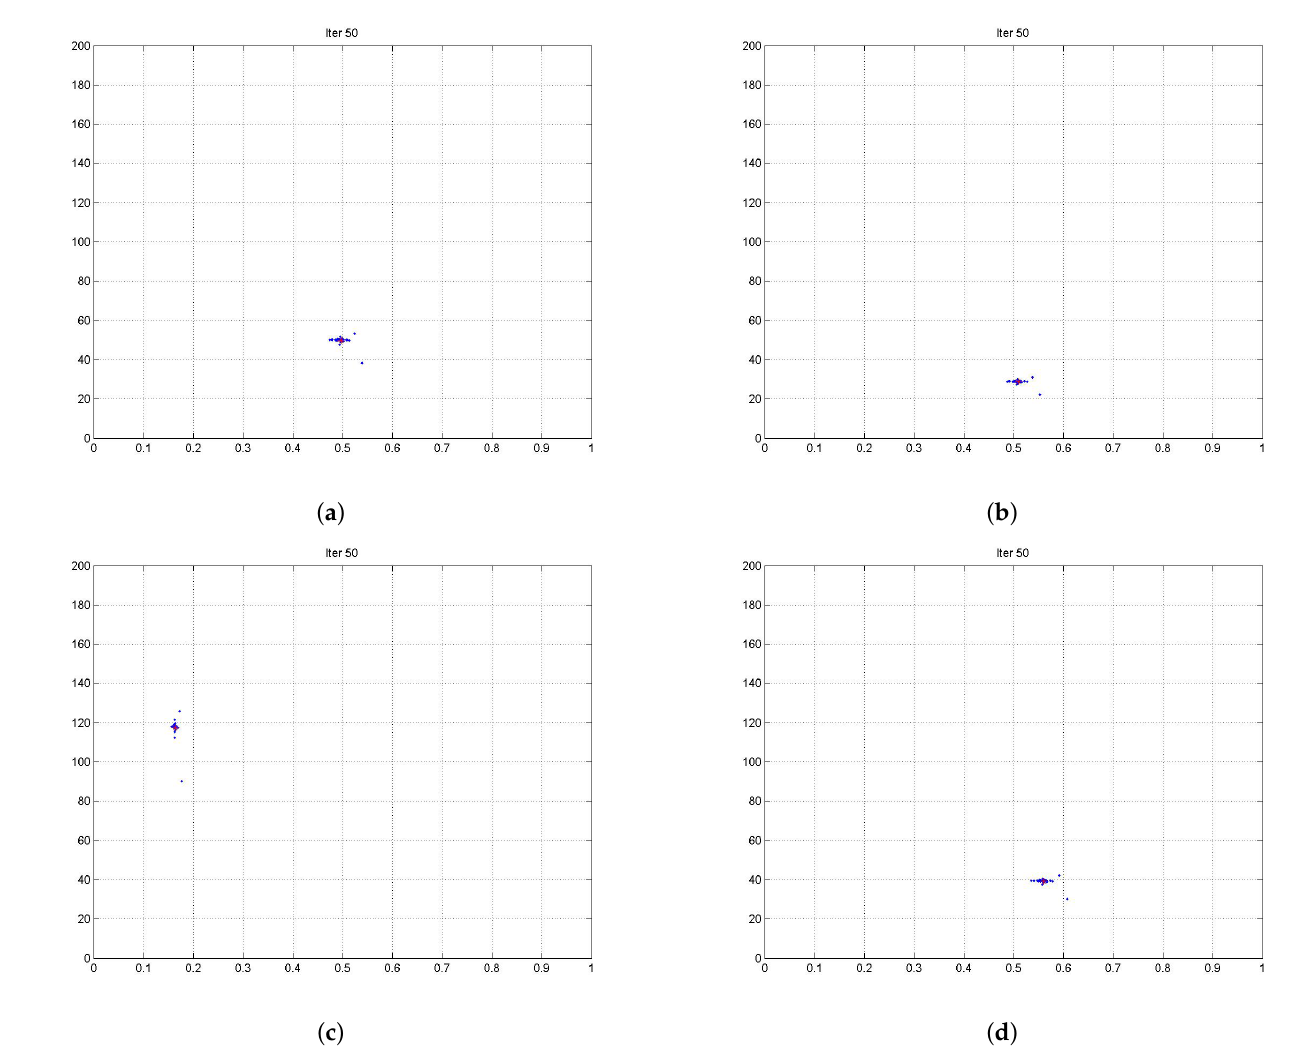
Figure 1. The convergence of particles in nested PSO algorithm for Michaelis–Menten model under various decision criteria. Vertical coordinate represents the value of the support point 1, and horizontal coordinate represents the weight of support point 1. ( a ) Michaelis–Menten model with pessimistic criterion; ( b ) Michaelis–Menten model with optimistic coefficient criterion, α = 0.7; ( c ) Michaelis–Menten model with optimistic coefficient criterion, α = 0.3; ( d ) Michaelis–Menten model with minimax regret